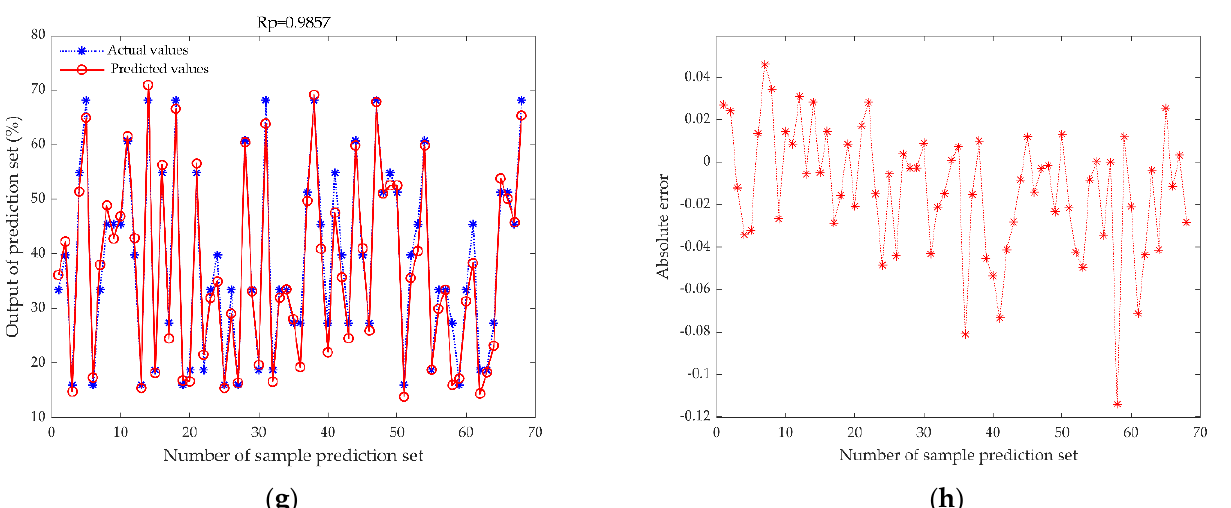
Figure 8. The prediction model of moisture content based on data fusion and single data. ( a ) SNV-ENN model’s scatter plot, ( b ) SNV-ENN model’s absolute error plot, ( c ) CV-ENN model’s scatter plot, ( d ) CV-ENN model’s absolute error plot, ( e ) MDF-ENN model’s scatter plot, ( f ) MDF-ENN model’s absolute error plot, ( g ) LDF-ENN model’s scatter plot, ( h ) LDF-ENN model’s absolute error plot. The actual values are the moisture content measured by the rapid moisture analyzer, the predicted values are the moisture content predicted by different models, and the absolute errors are equal to the predicted value minus the actual value.